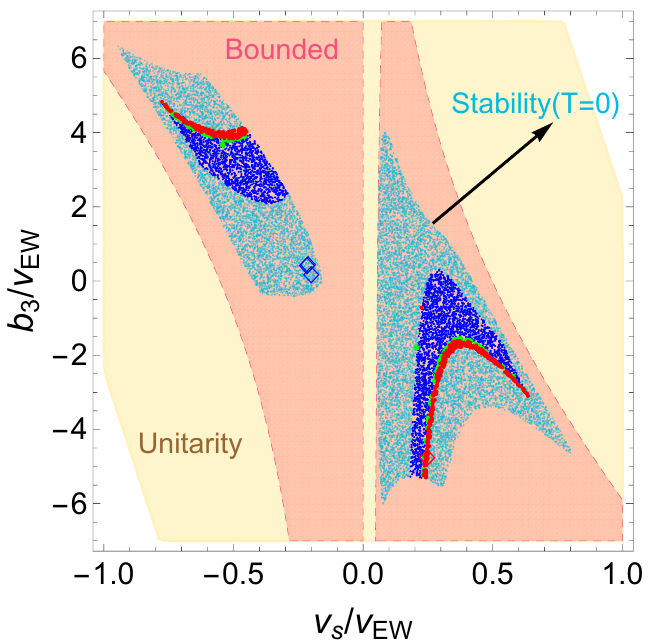
Figure 1 . An illustrative plot showing various phenomenological constraints. The shaded regions are allowed by requirements of unitarity, boundedness of the potential from below, and stability of EW vacuum at zero temperature. Points are also overlapped on this plot where various EWPT criteria are ful(cid:12)lled and with SNR > 50 (red), 50 > SNR > 10 (green) and SNR < 10 (blue). The diamond-shaped points give two-step